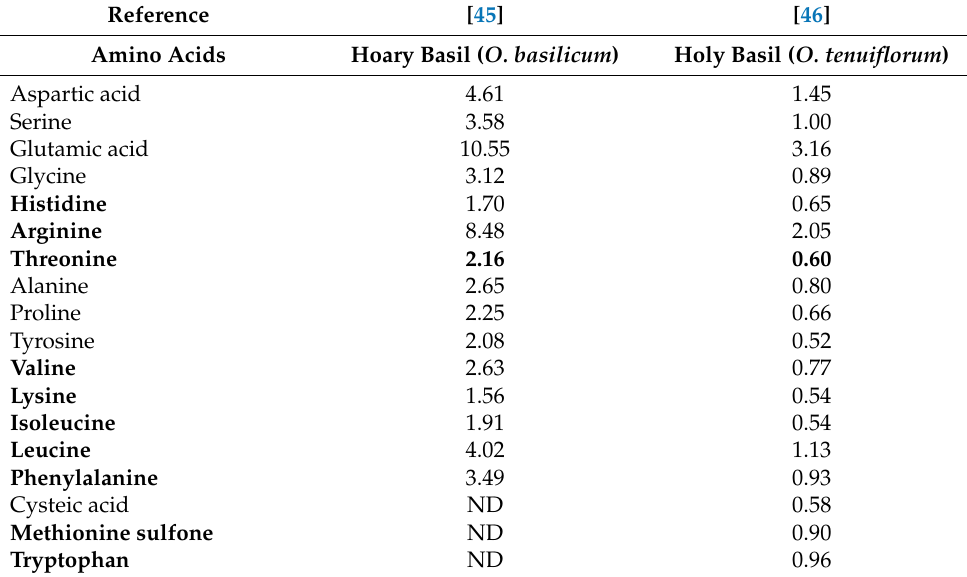
Table 3. The amino acid composition of basil seeds (mg/100 mg).